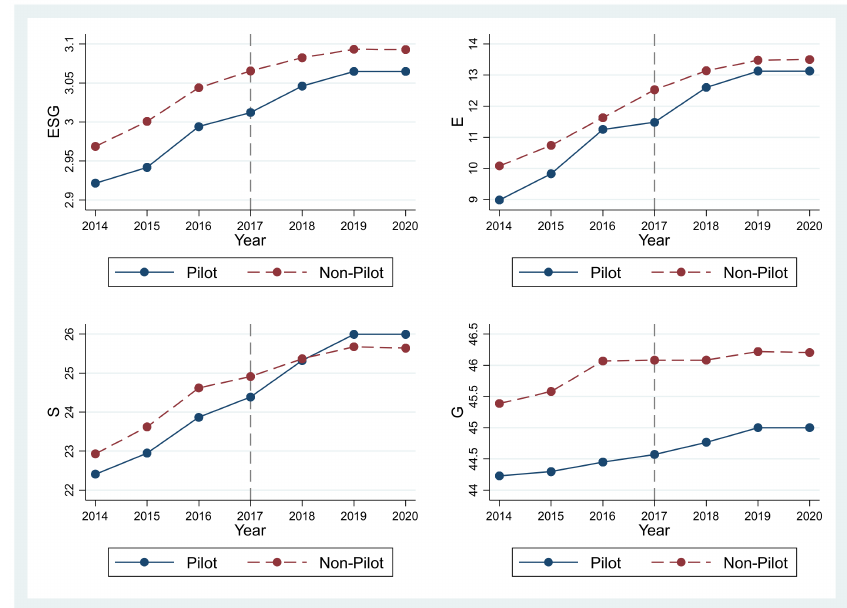
Figure 1. Time trend